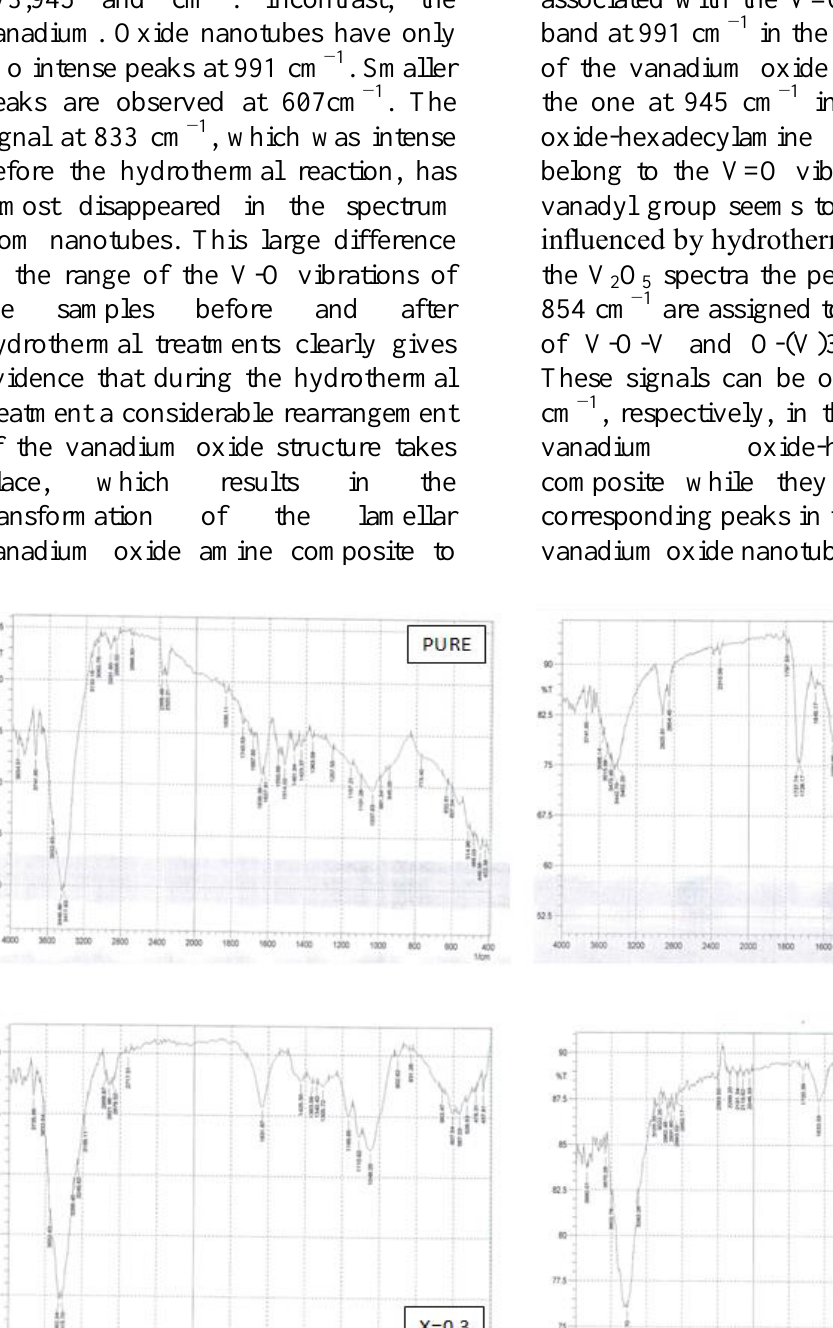
O ) (TiO ) films at RT with different TiO 2 5 1-x 2 x